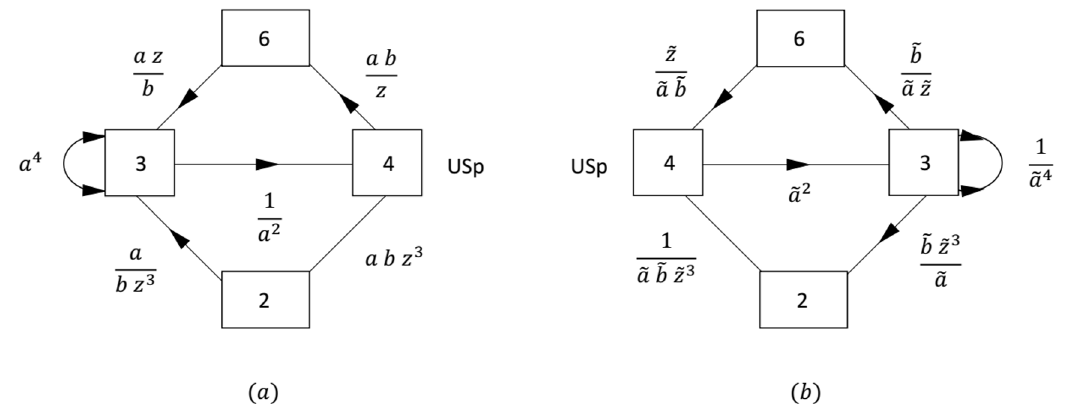
Figure 22 . The theories associated with the compactification of the SU(2) × SO(16) 5 d SCFT on a tube. Here both (a) and (b) describe the same tube, differing by charge conjugation. Charges under the global symmetries are denoted using fugacities. Here we have also split the 8 chirals on the two sides to 6 + 2 , and correspondingly only the SU(6) × SU(2) × U(1) subgroup of the SU(8) global symmetry is manifest in the